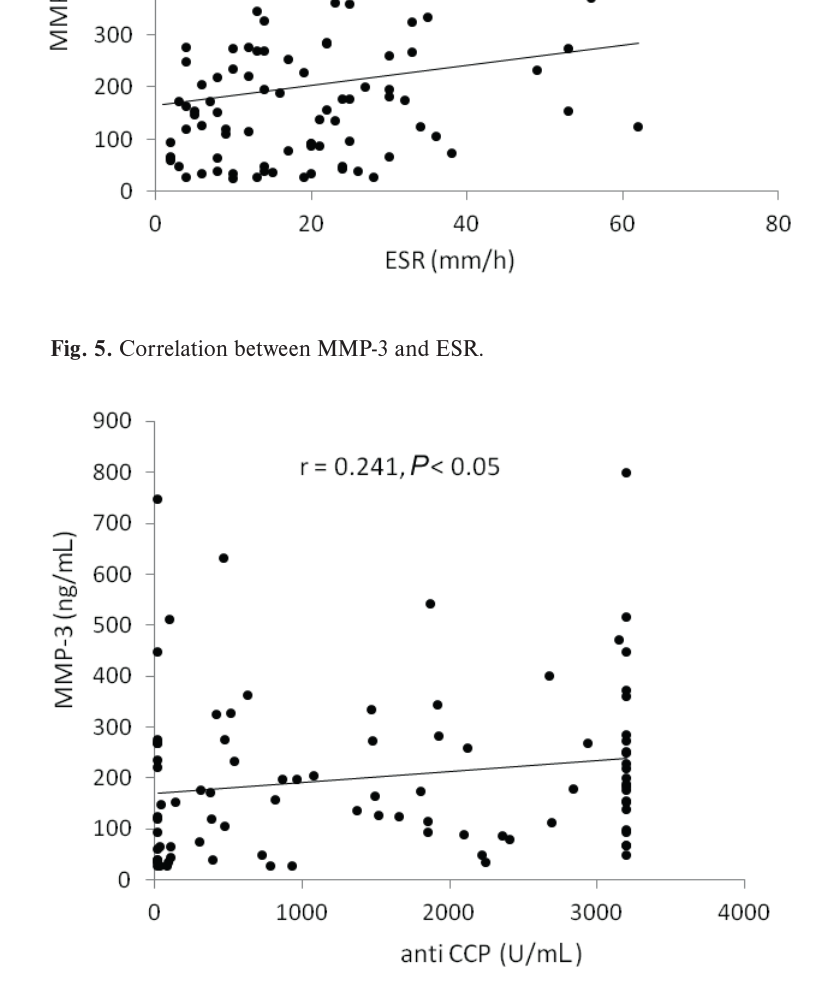
Fig. 6. Correlation between MMP-3 and anti CCP